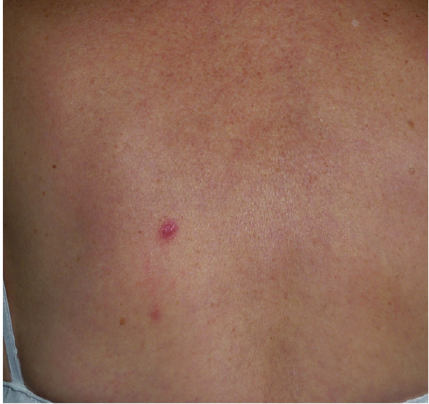
Figure 5: Second lesion. See similarity with the first nodule. Erythematous plaque of 0.7cm in